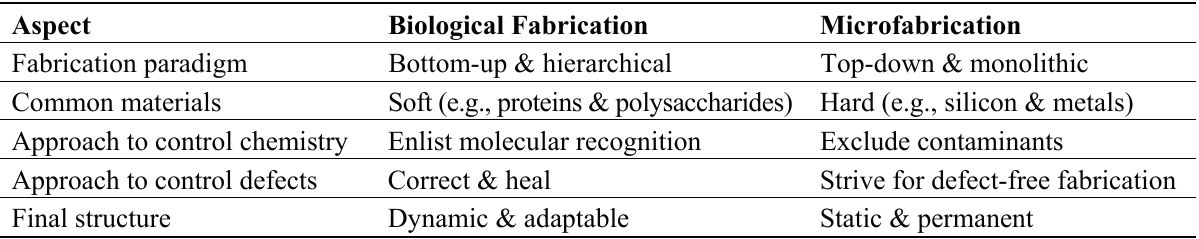
Table 3. Divergent fabrication paradigms for electronics and